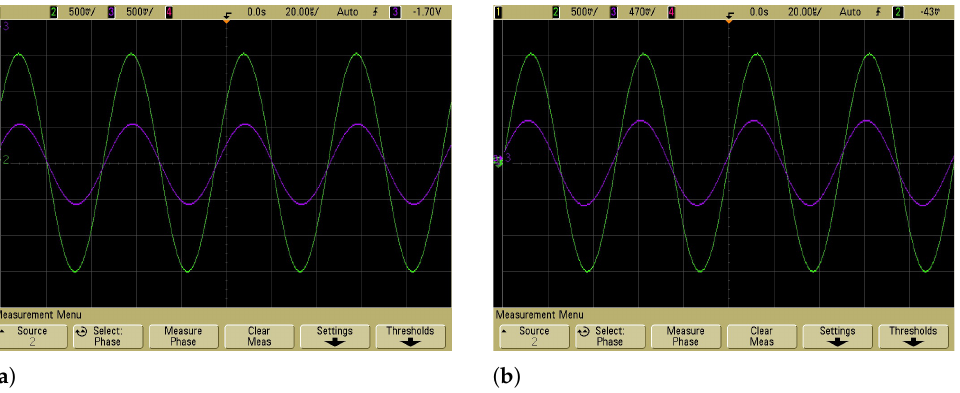
Figure 12. Input and output waveforms of filters of order 0.26, realized by ( a ) the topology in Figure 4a, and ( b ) the topology in Figure 4b, stimulated by a (3 V p-p , 20 kHz) sinusoidal input. In the case of the inverse filters topologies in Figure 5, the same procedure as above has been followed. Considering a minimum/maximum gain equal to one and a char- acteristic frequency of 20kHz for both filters, then the required integer-order capaci- tors will be both C 1 = C 2 = 109 pF (110 pF was the employed value) for the inverse low pass filter and C 1 = C 2 = 564 pF (562 pF the employed value) for the inverse high pass filter. The corresponding frequency and time-domain responses are depicted in Figures 13a,b and 14a,b, respectively. The set of values of gain and phase, obtained from the waveforms in Figure 14a,b, are (1.39, 7.8 o ) and (1.48, − 7.9 o ), while the theoretical ones are (1.41, 7.1 o ) and (1.41, − 7.1 o ), respectively.